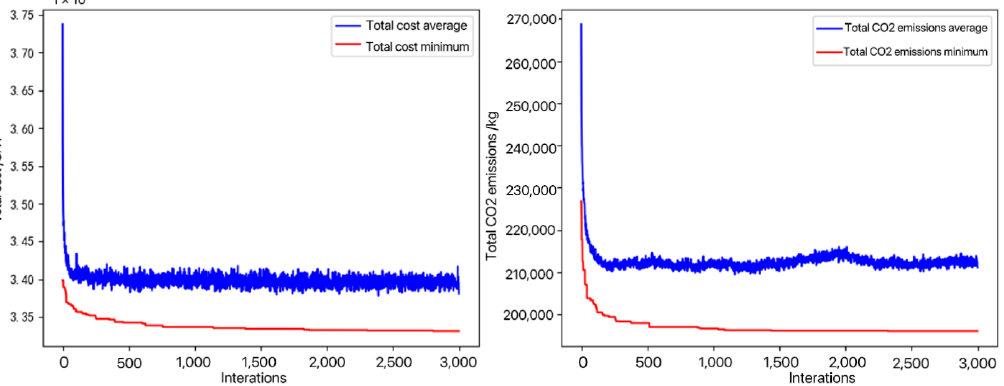
Figure 13. Plot of the total cost – number of iterations, total carbon dioxide emissions – number of iterations c (M = 3000) .